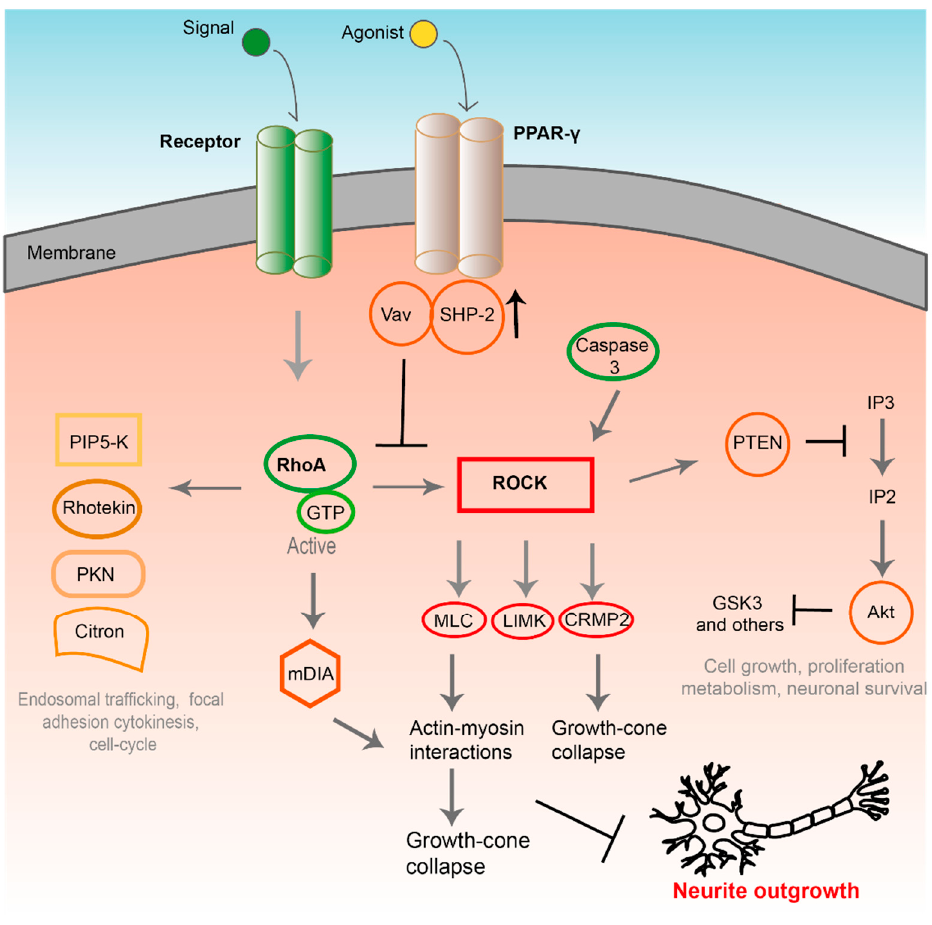
Figure 2. PPAR- γ receptor and its effect on downstream pathways that are potential targets for drug agents. Including the Rho/ROCK inhibitory pathway which when blocked stops growth-cone collapse and encourages neurite outgrowth. Proliferator-activated receptor gamma (PPAR- γ ), Src homology region 2–containing protein tyrosine phosphatase-2 (SHP-2), Ras homolog family member A (RhoA), guanosin-5 ′ -triphosphate (GTP), phosphatidylinositol 4-phosphate-5 kinase (PIP5K), protein kinase N (PKN), Rho-associated kinase (ROCK), myosin light chain (MLC), LIM kinase (LIMK) and collapsin response mediator protein 2 (CRMP2), phosphatase and tensin homolog (PTEN), inositol triphosphate (IP3), inositol biphosphate (IP2), serine/threonine protein kinase B (Akt) [19] .